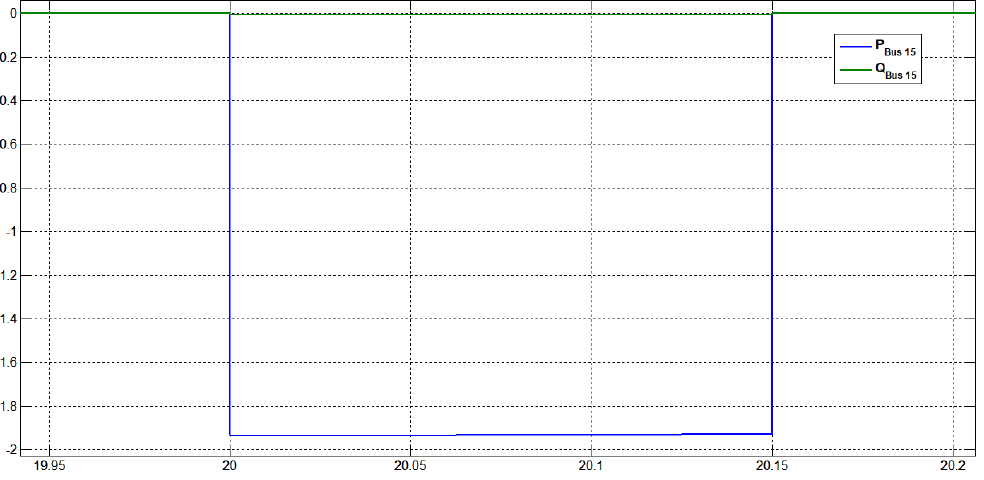
Figure 38. Generated active and reactive power at bus 15 under a three ‐ phase short circuit bus 15.